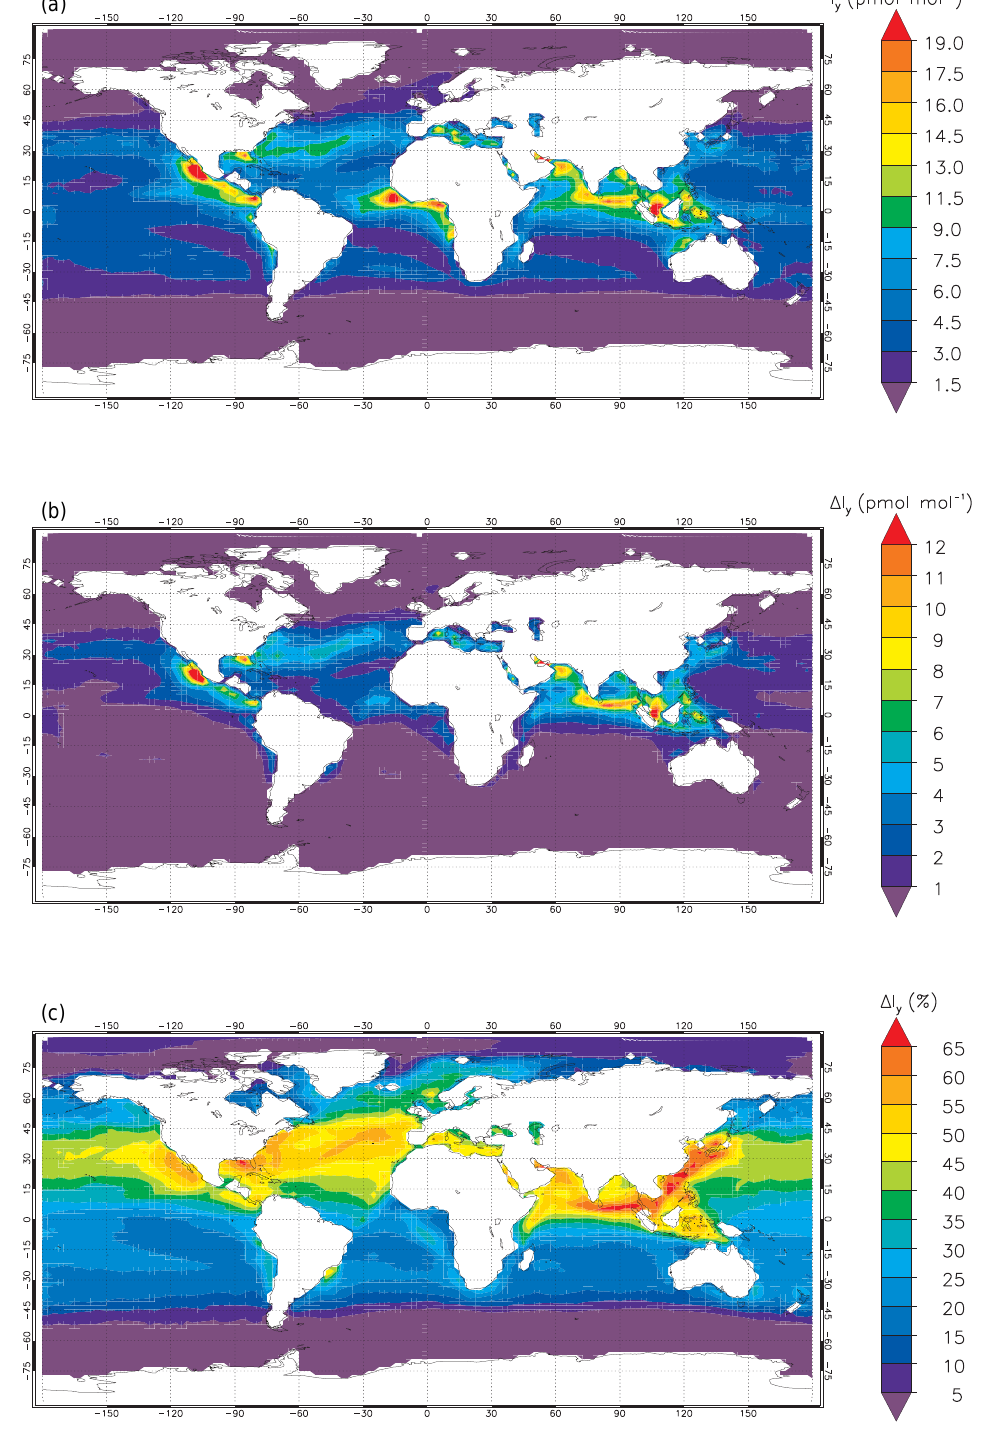
Figure 5. Geographical distribution of the budget of total gaseous inorganic iodine (I y = I + IO + HOI + IONO 2 + HI + OIO + NO + INO 2 + 2 × I 2 + IBr + ICl + 2 × I 2 O x , with x = 2–4) in the MBL: (a) modelled I y mixing ratio in the PD scheme; (b) enhancement of the I y budget since pre-industrial times (PD-PI); (c) percentage increase in the I y budget since industrial revolution, i.e. 100 ×